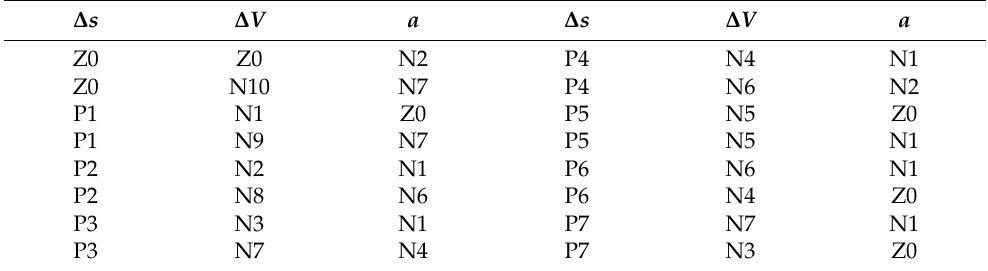
Table 4. Processing results.